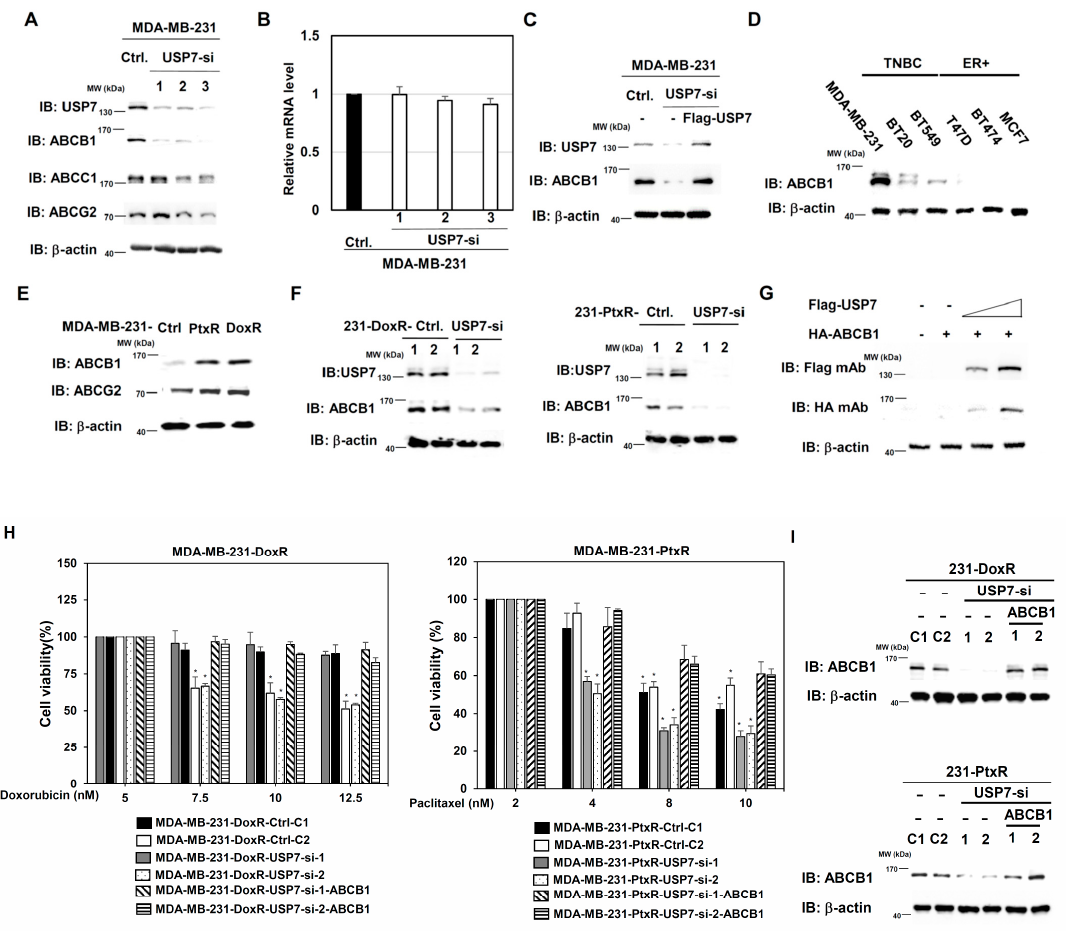
Figure 8. ABCB1 expression is upregulated by USP7 in chemo-drug resistant TNBC. ( A ) Levels of ABC family members in MDA-MB-231 cells with USP7 suppression, by western blot analysis with specific antibodies. ( B ). Analysis of the level of ABCB1 mRNA in MDA-MB-231 cells with USP7- suppression, assessed performing quantitative-RT-PCR analysis. ( C ) ABCB1 levels in MDA-MB- 231-USP7-silencing cells with USP7-re-expression, by western blot analysis with specific antibodies. ( D ) Level of ABCB1 in triple-negative and ER-positive breast cell lines, assessed using western blot analysis with specific antibodies. ( E ) Levels of ABCB1 and ABCG2 in MDA-MB-231-DoxR and MDA-MB-231-PtxR cells, assessed using western blot analysis with specific antibodies. ( F ) Levels of ABCB1 in MAD-MB-231-DoxR (left) and MDA-MB-231-PtxR (right) cells with USP7-suppression, assessed using western blot analysis with specific antibodies. ( G ) ABCB1 protein expressions in 293T cell with transient dose-dependent overexpression of USP7, by western blot analysis with spe- cific antibodies. ( H ) Cell viability of MDA-MB-231-DoxR-USP7-silencing (left) and MDA-MB-231- PtxR-USP7-silencing (right) cells with empty vector/ABCB1 expression treated with serial doses of doxorubicin or paclitaxel, assessed performing MTT assays. ( I ) Expression levels of ABCB1 in MDA- MB-231-DoxR-USP7-silencing (upper) and MDA-MB-231-PtxR-USP7-silencing (lower) cells with empty vector/ABCB1 expression, by western blot analysis with specific antibodies. Data are repre- sented as the mean ± SEM for biological triplicate experiments. * p < 0.05, compared with cells with steady concentration of doxorubicin and paclitaxel, respectively.